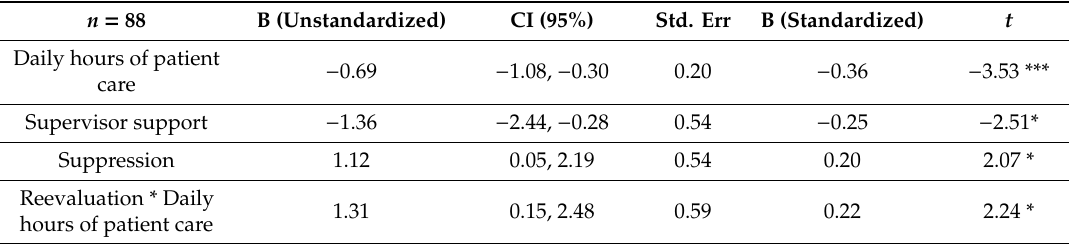
Table 5. Linear regression model results for the depersonalization subscale.